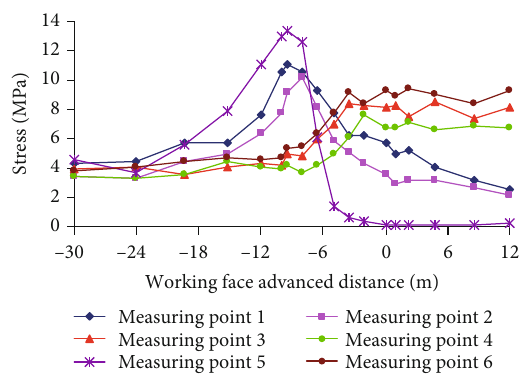
Figure 7: The variation in stress at the measuring points.